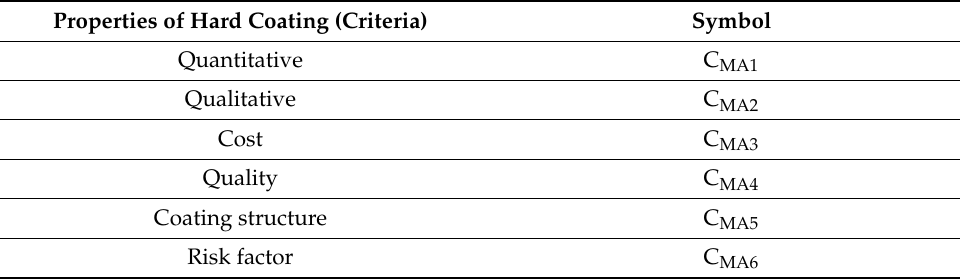
Table 16. Evaluation criteria of coating materials.